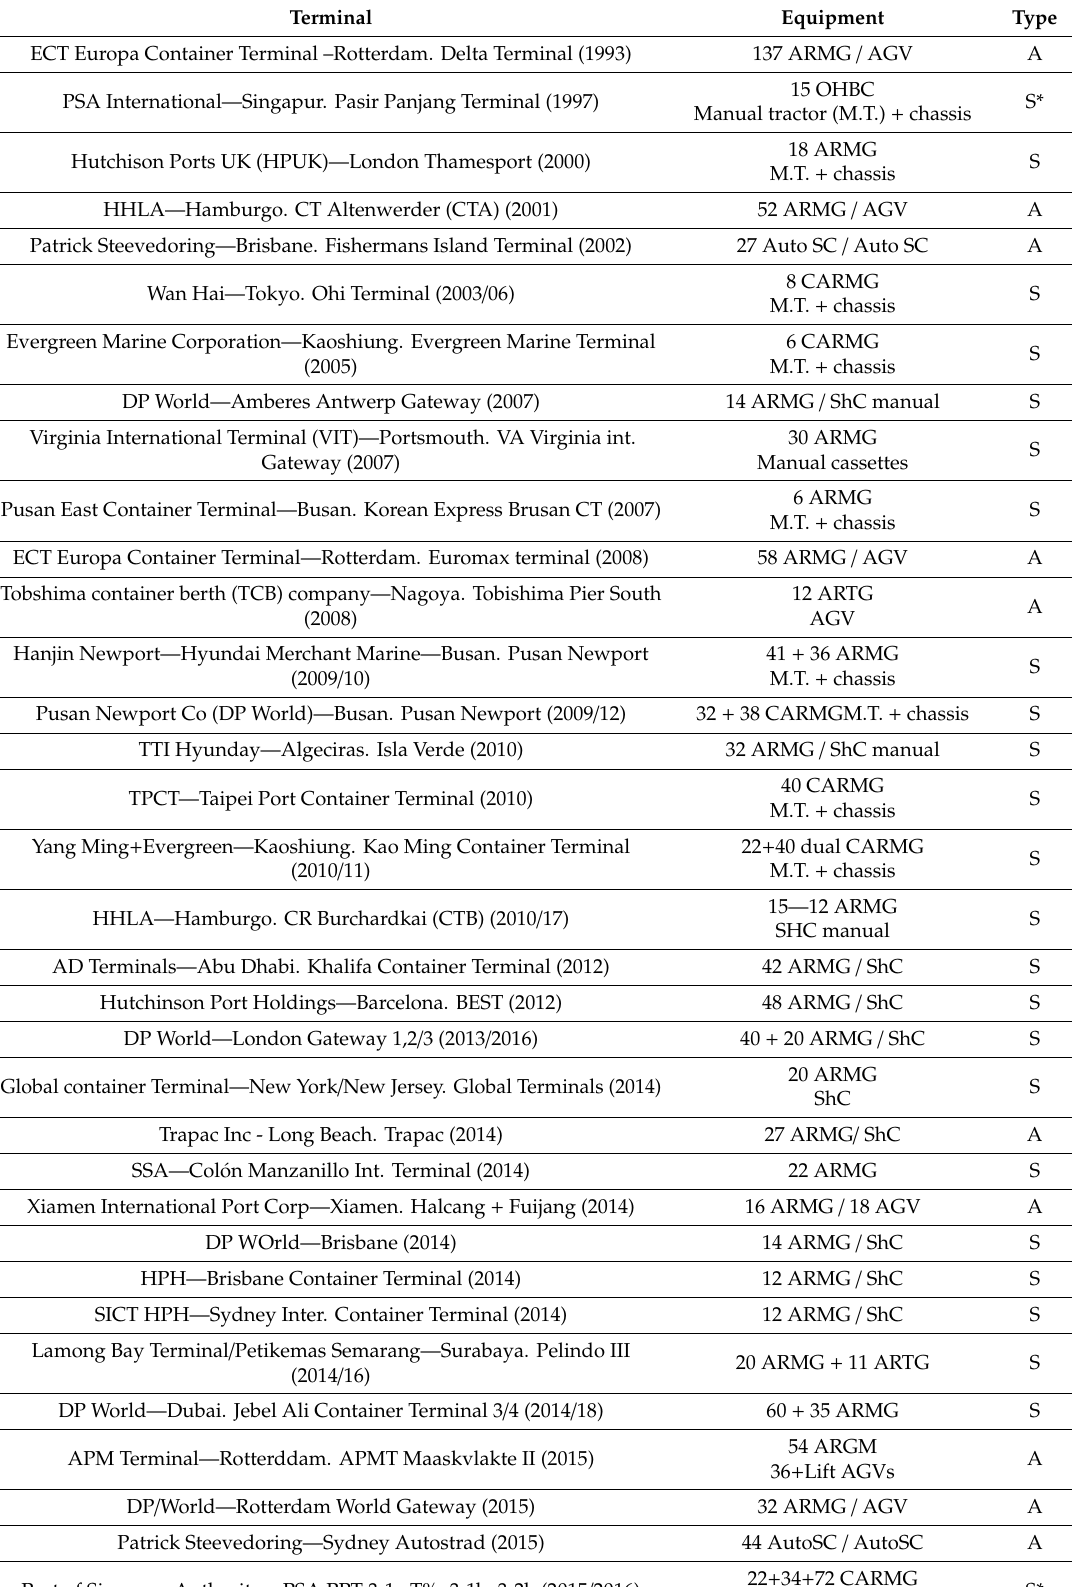
Table 1. Main automated (A) and semi-automated (S) terminals in chronological